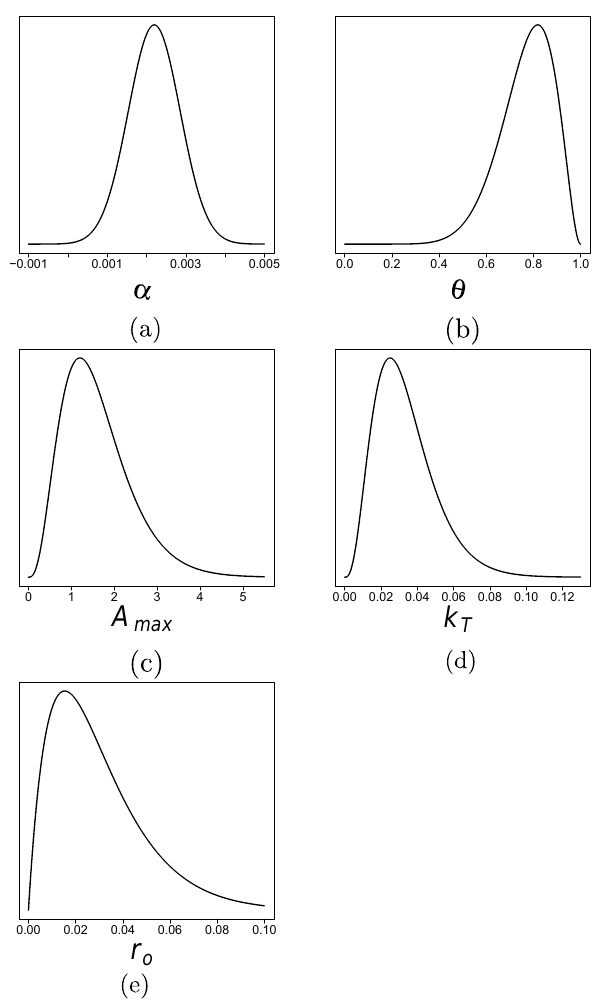
Figure 1. Informative prior distribution of the NRH model